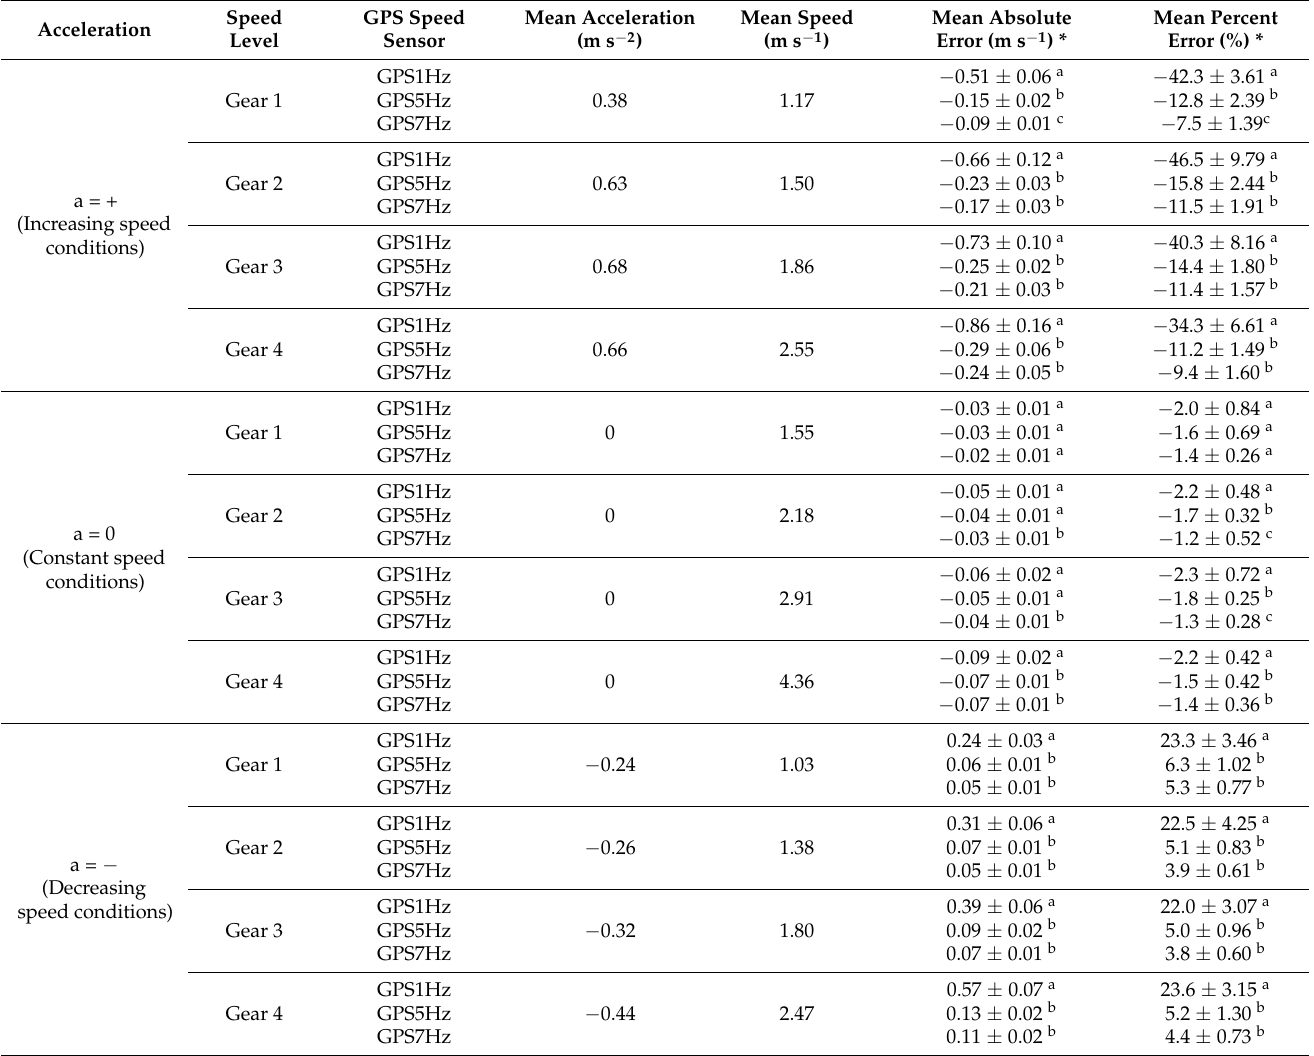
Table 4. Mean speed error values of the three GPS speed